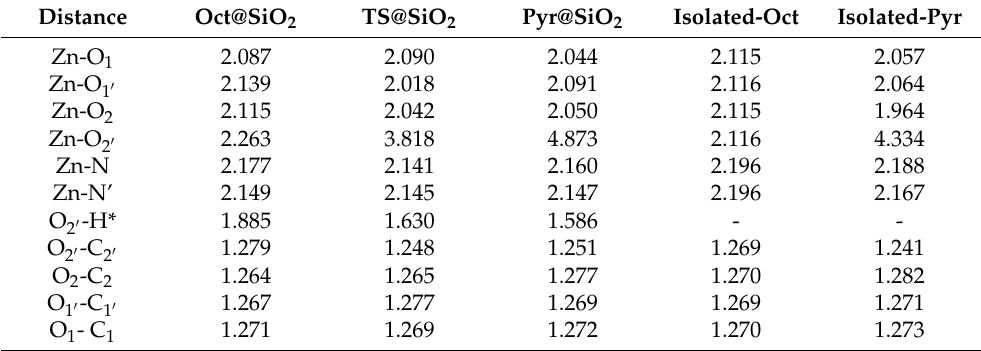
Table 4. Geometrical parameters of the octahedral (Oct), pyramidal (Pyr), and transition state (TS) structures of the Zn complex adsorbed on the hydroxylated SiO 2 surface at the PBE-D2/PW level. Isolated complex data at the same theory level are reported to facilitate comparison. Distances in